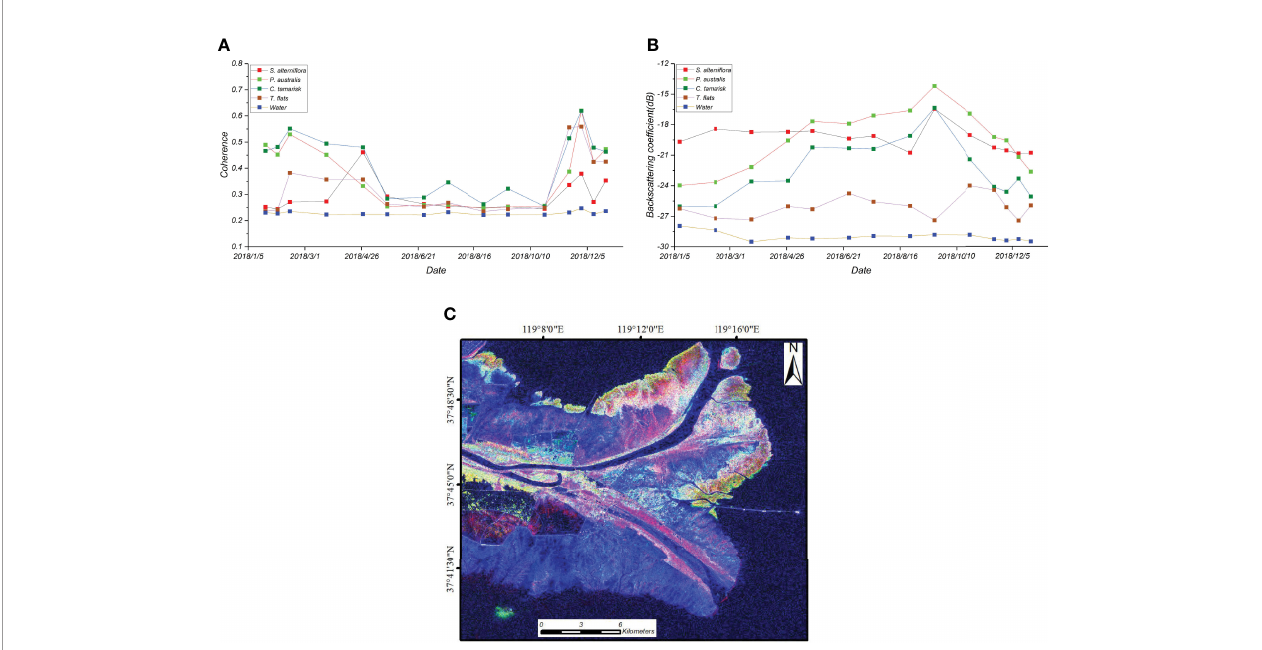
FIGURE 8 | Multi-temporal classi fi cation preprocessing. (A) is statistical time series coherence curve in 2018; (B) is statistical time series backscattering coef fi cient curve in 2018; (C) is multi-temporal composite pseudocolor image. Note that the horizontal axis represents the date of the slave image of interferometric pairs, that is, January 22 represents the acquisition date of slave image of interferometric pairs between January 10 and January